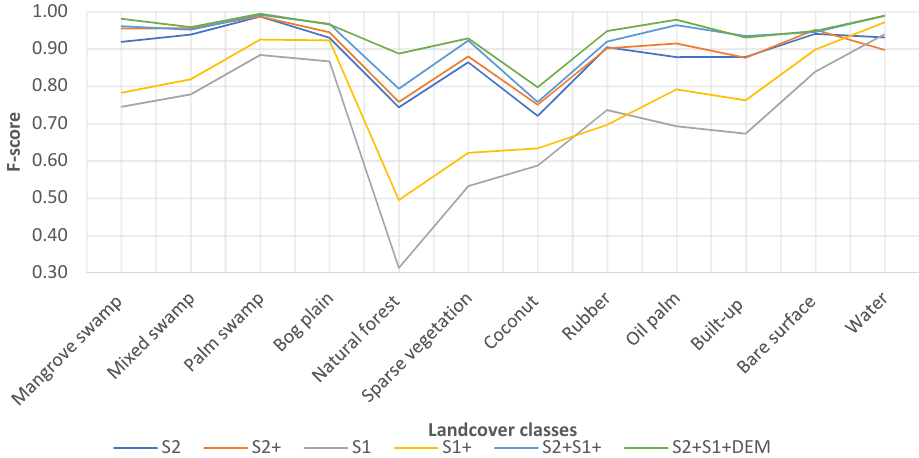
Figure 6. F-score of landcover classes from the classification results of various datasets.